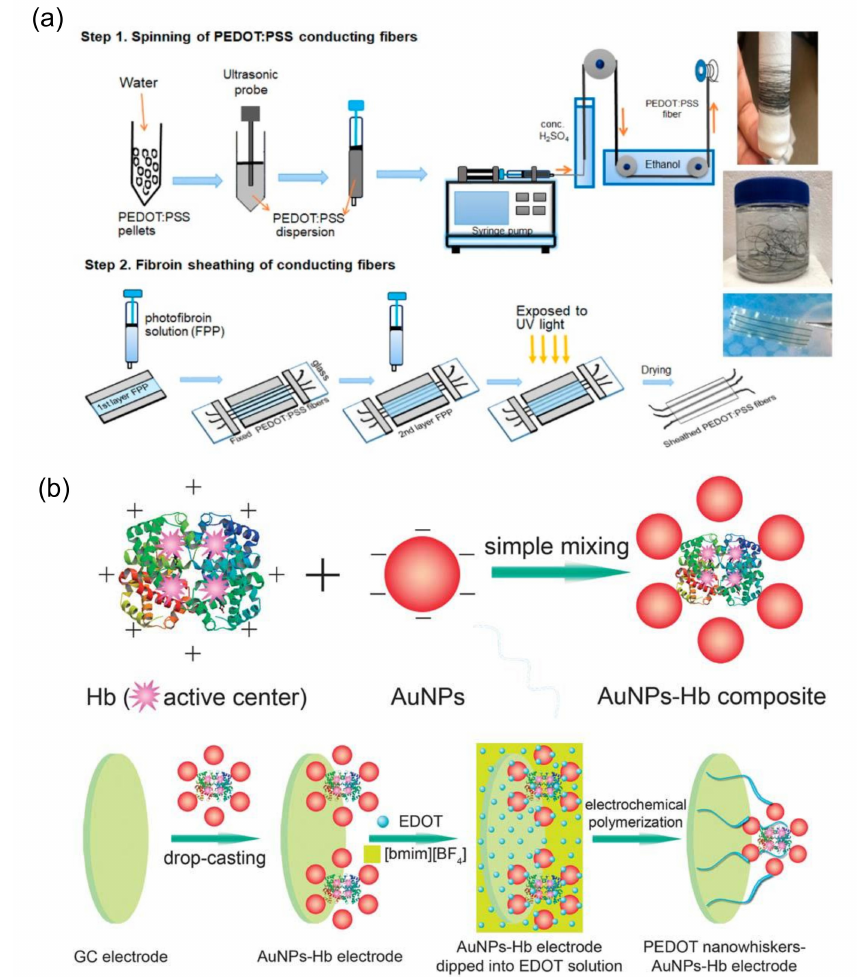
Figure 9. ( a ) PANI:PSS / silk fibroin core / shell wires derived via wet spinning and photo